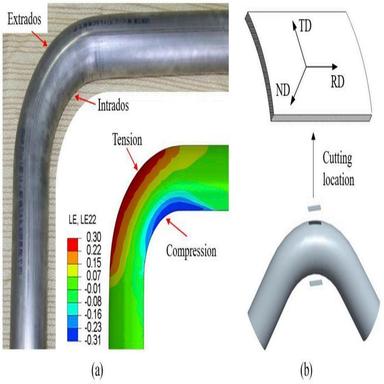
Schematic of (a) the T-C asymmetry in the HRDB and (b) the measuring locations of pole figures.